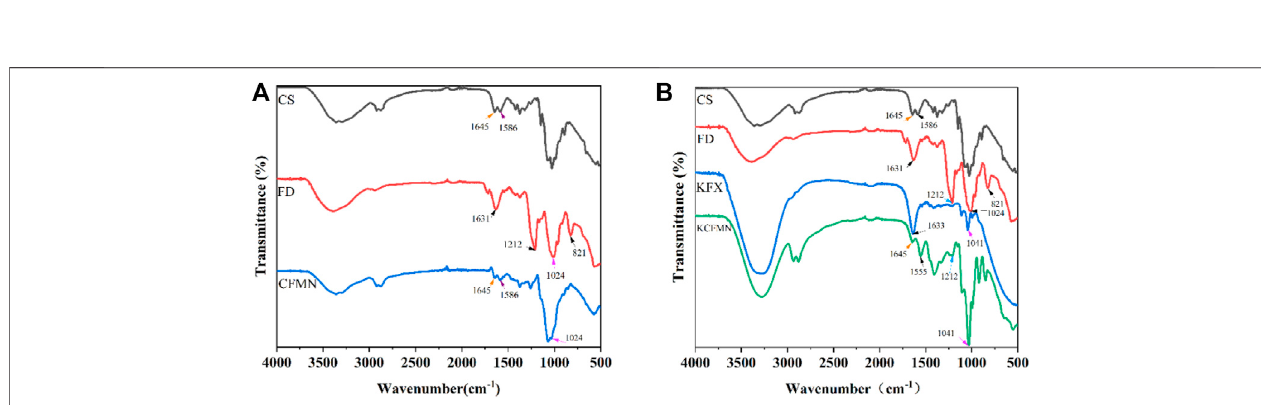
FIGURE 3 | (A) FTIR spectra of CS, FD, and CFMN (B) FTIR spectra of CS, FD, KFX, and KCFMN.